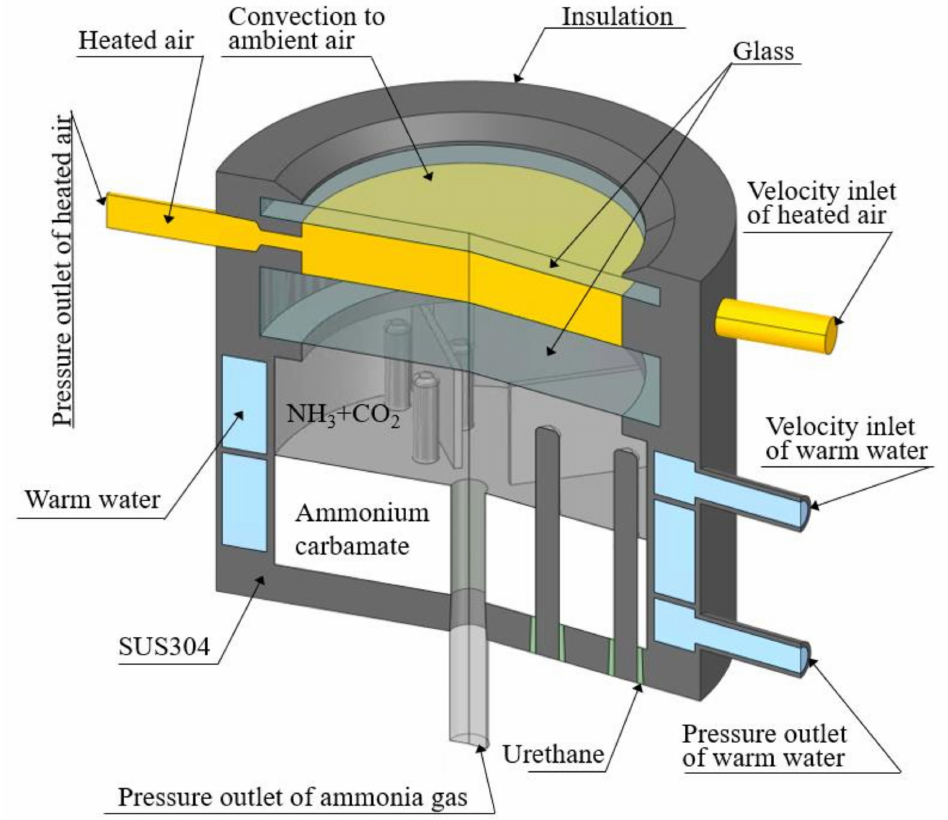
Figure 4. Schematic diagram and boundary definitions of AC sublimation model